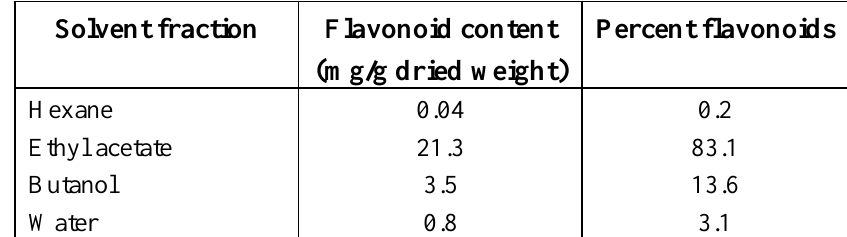
Table 2. Comparison of flavonoid contents in hexane, ethyl acetate, butanol and water fractions of litchi fruit pericarp tissues